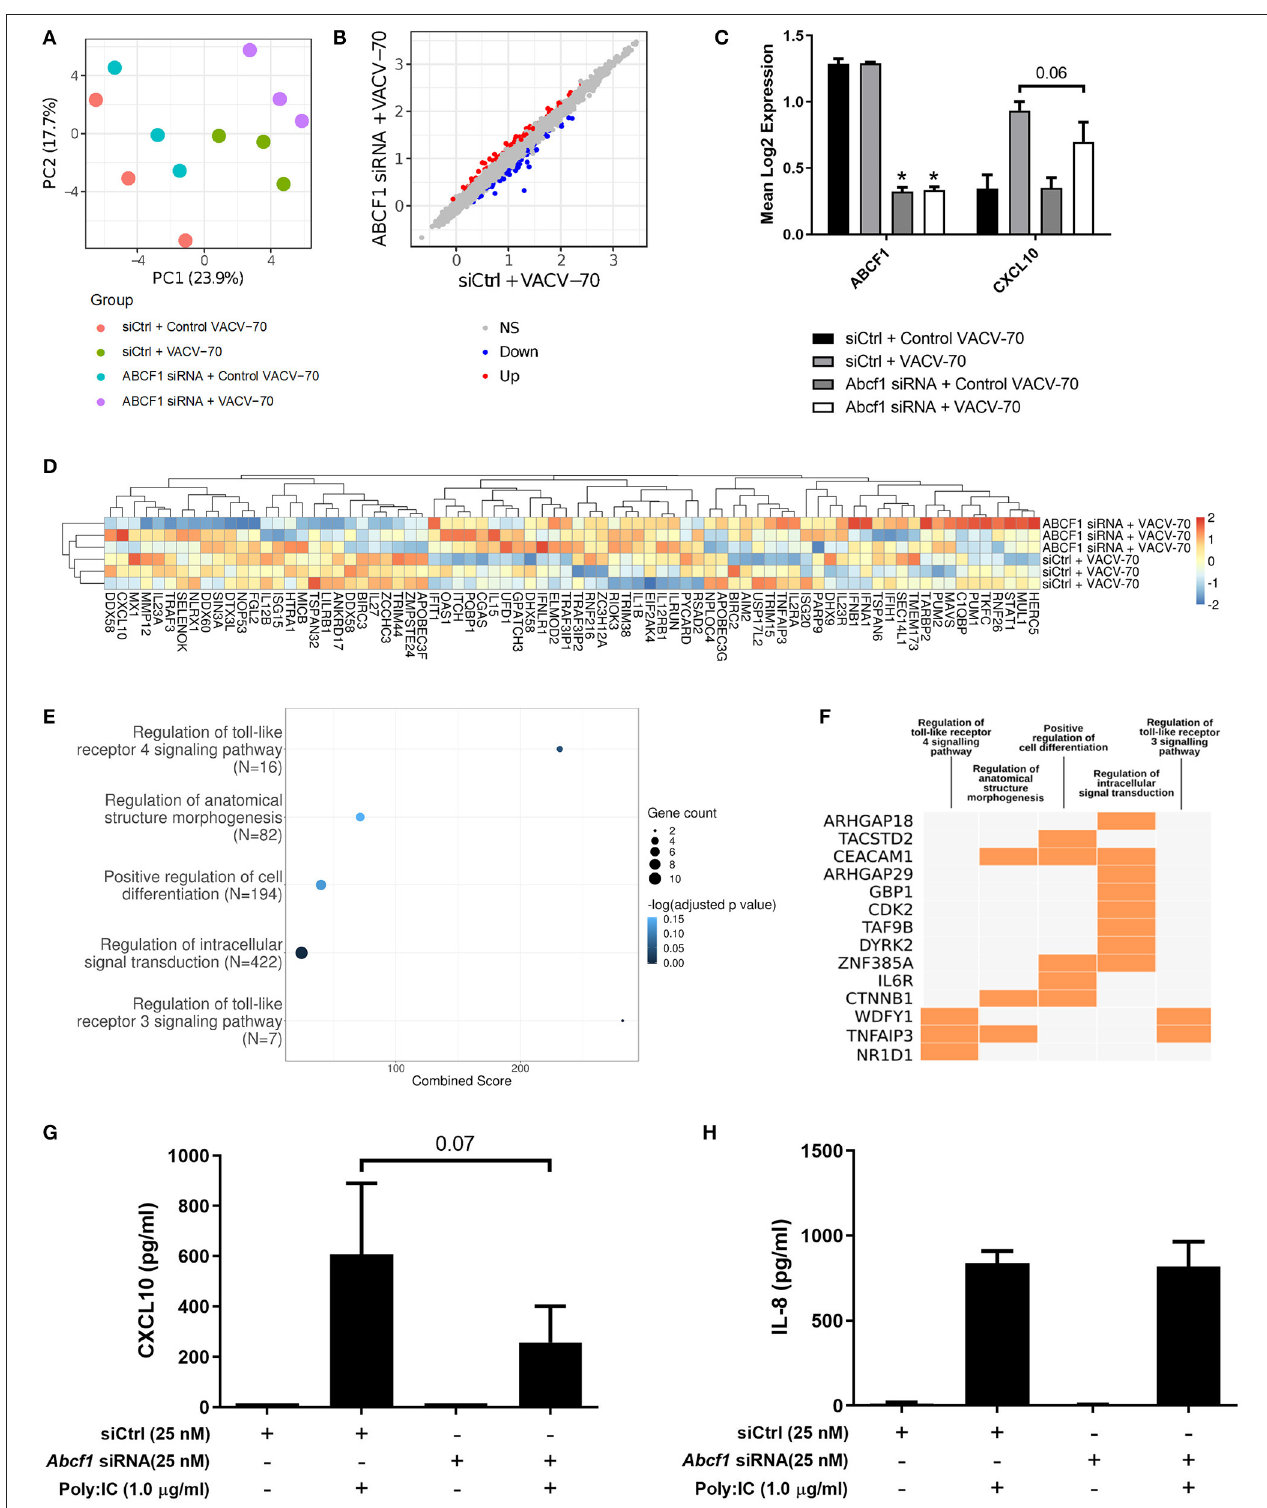
FIGURE 6 | Transcriptional interrogation of ABCF1 function during VACV-70 challenge in HBEC-6KT. (A) PCA plot of microarray gene expression profiles of HBEC-6KT cells following ABCF1 knockdown and VACV-70 treatment. Red circles (control siRNA and control VACV-70), green circles (control siRNA and